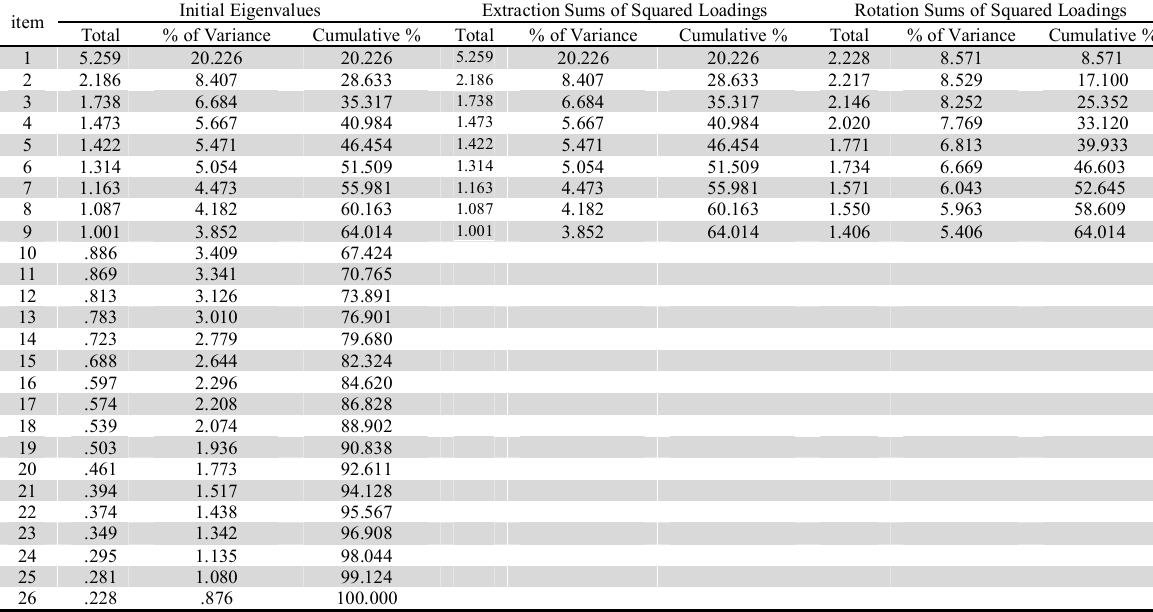
The summary of total variance explained before rotation